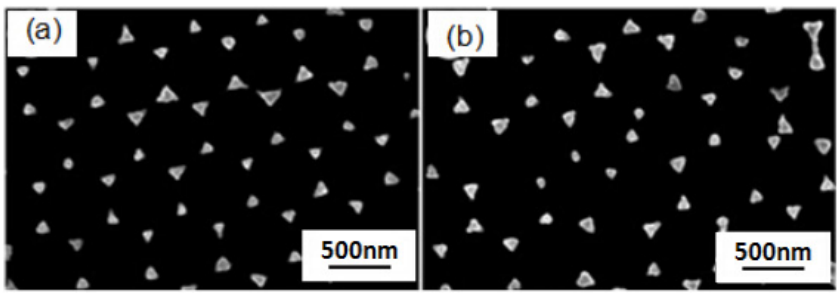
Figure 4. SEM images of two-dimensional ordered Au-Ag nanoparticle arrays as a function of the coating method of the PS nanosphere mask. ( a ) Drop-coating method; and ( b ) spin-coating method.